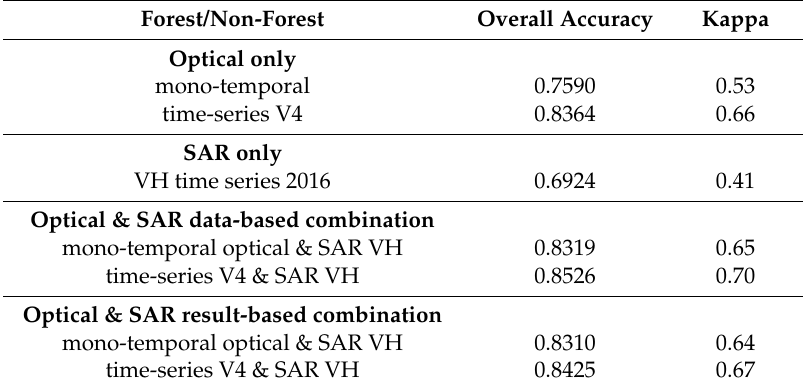
Table 5. Accuracies of optical/SAR only and optical/SAR combined approaches for FNF maps.